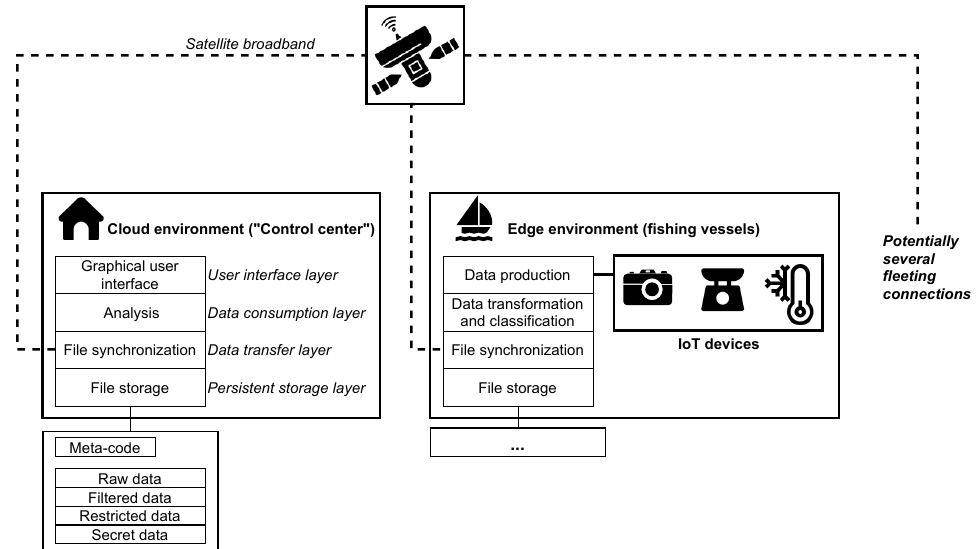
Figure 1. The horizontal and vertical distribution of data, software components, and devices in the Dutkat